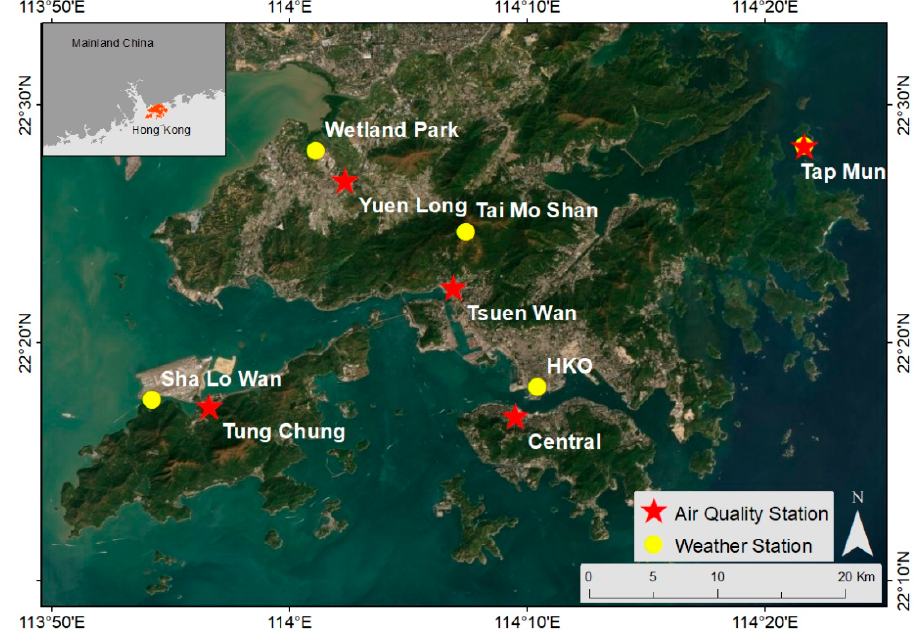
Figure 1. Study area and locations of ground-based air quality monitoring stations (stars) and the Hong Kong Observatory’s climate stations (circles) in the hilly and complex terrain of Hong Kong. Table 1. Description of air quality monitoring sites used in this study. 1 AQMS